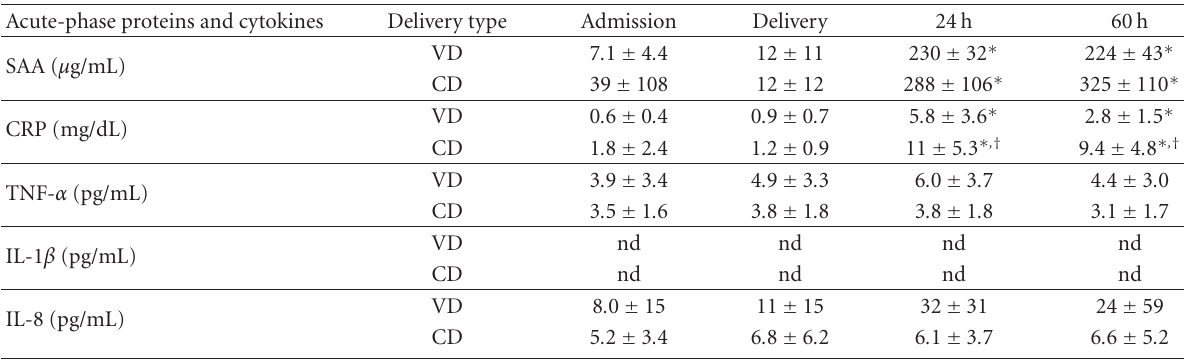
Table 1. Concentration of acute-phase proteins and cytokines in maternal serum upon admission for delivery, at the moment of delivery, and after delivery (24 and 60 hours) in vaginal delivery (VD), where n = 12 and Cesarean section (CD), where n = 12. Values are mean and standard deviation. nd denotes nondetectable. ∗ denotes that P < . 01 compared to admission and moment of delivery and † denotes that P = . 01: CD di ff ered from VD (variance analysis). Acute-phase proteins and